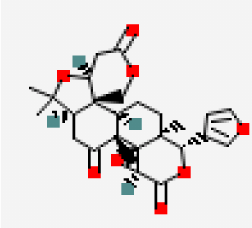
Figure 2. Chemical structure of Limonin (Available online: https://pubchem.ncbi.nlm.nih.gov, accessed on 10 December